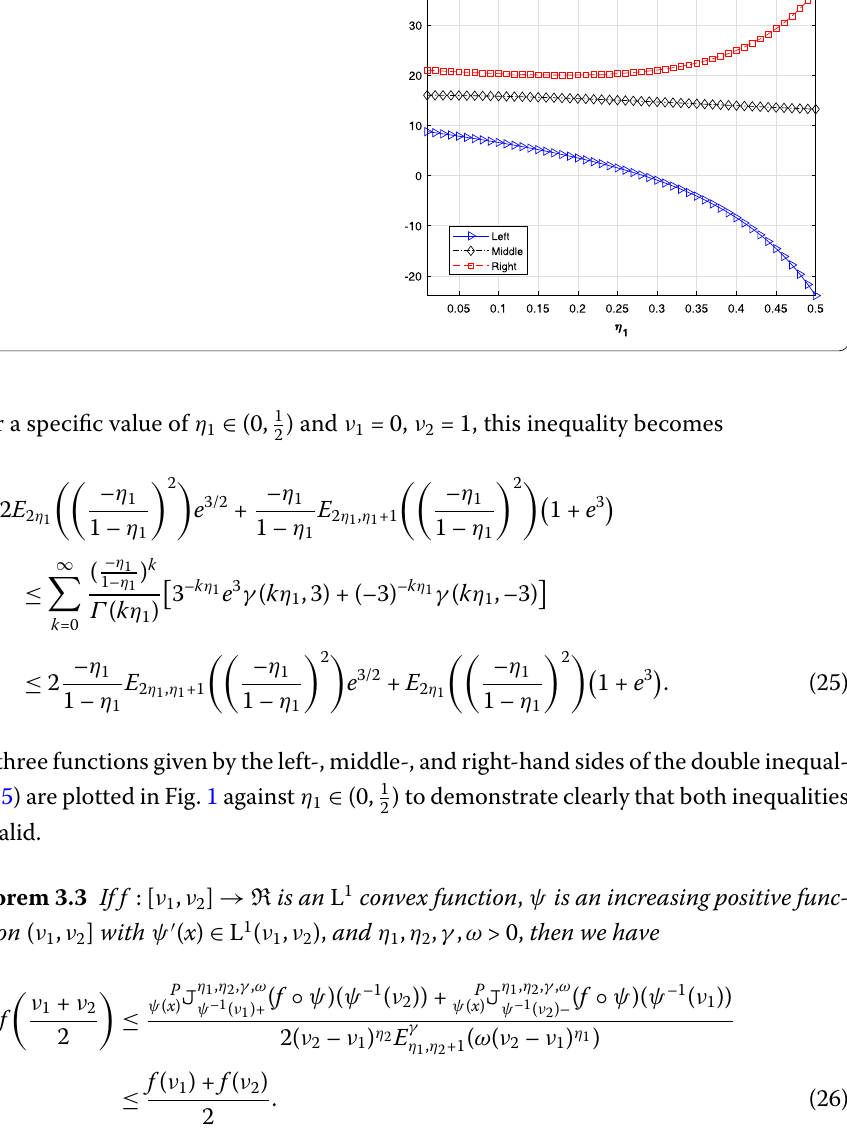
Figure 1 A plot illustration for Example